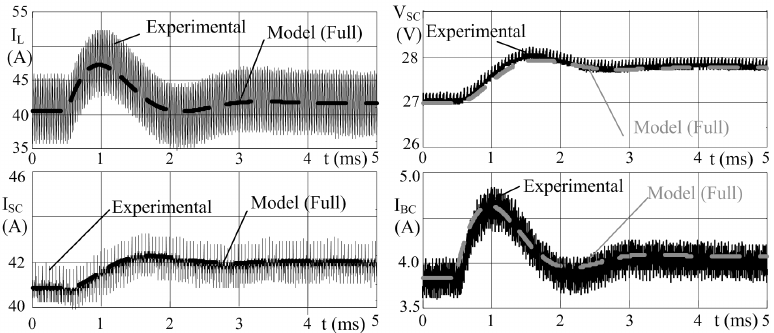
Figure 21. Experimental waveforms (gray) and averaged value of model based on real components (black), for filter current ( I L ), load output current ( I SC ), load voltage ( V SC ), and input current ( I BC ).